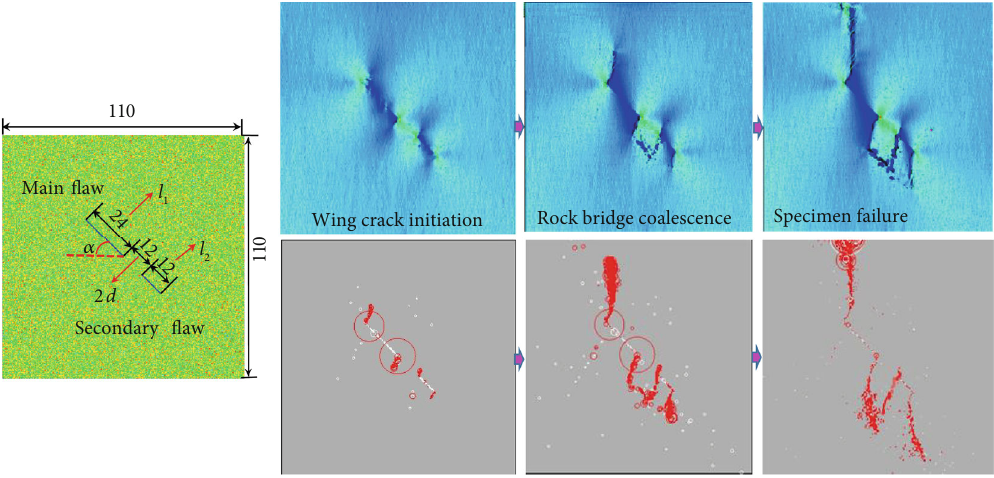
= 24mm , 2 l = 12mm , 2 d = 12mm 1 2